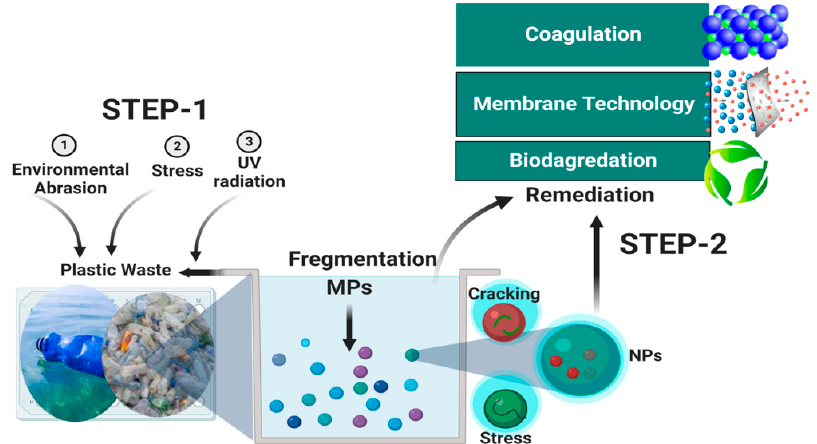
Figure 2. A schematic diagram showing the mechanism of plastic waste degradation to MNPs and the common remediation technologies. the common remediation